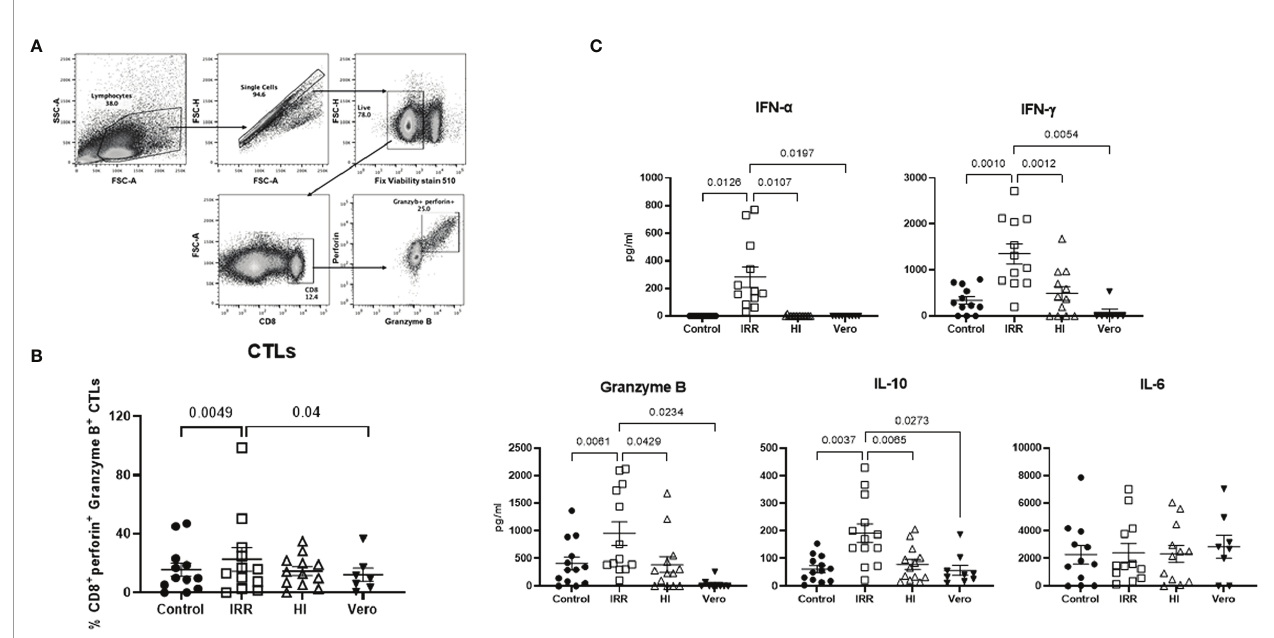
FIGURE 2 | Irradiated SARS-CoV-2 is a better inducer of cytotoxic T lymphocytes than heat-inactivated SARS-CoV-2. PBMCs stimulated with irradiated SARS- CoV-2 (IRR) or heat-inactivated (HI) or Vero cell lysate (Vero) were cultured for 7 days. Cells collected were stained for CD8, perforin, and granzyme B and acquired on a fl ow cytometer. (A) Gating strategy for the identi fi cation of these cells. (B) Dot plot depicts the % of cytotoxic CD8 T cells. (C) Quantitation of cytokines/ chemokines in the supernatant by multiplex. Mean ± SE. N = 12 subjects. p -value was calculated using one-way ANOVA followed by Tukey ’ s